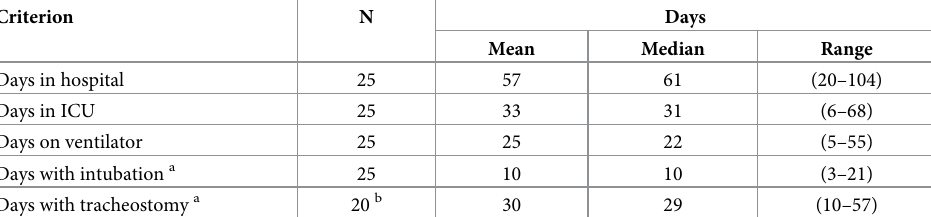
Table 3. Total time in hospital and number of days in ICU, on ventilator, with intubation, and with tracheostomy (mean, median, and